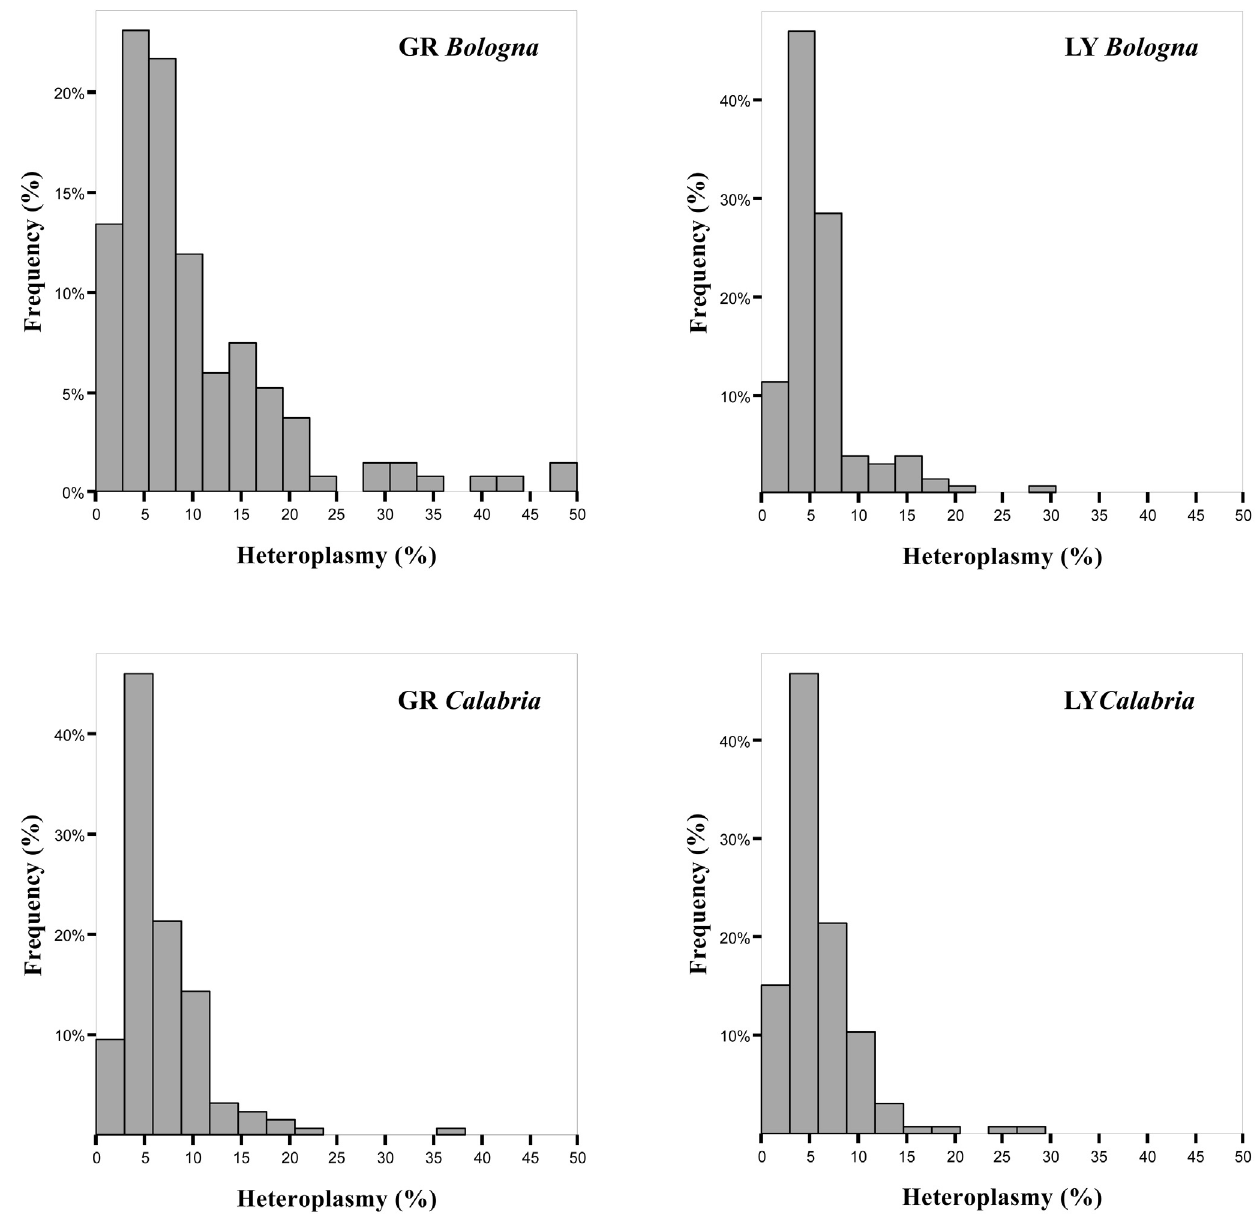
Figure 1. Heteroplasmy distribution in samples from northern and southern Italian sib-pairs. The histograms show the levels of heteroplasmy in Granulocytes (GR) and Lymphomonocytes (LY) of sib-pairs. The percentages of heteroplasmy are estimated on a DHPLC reference curve [10]. Northern Italian: Bologna; southern Italian: Calabria.